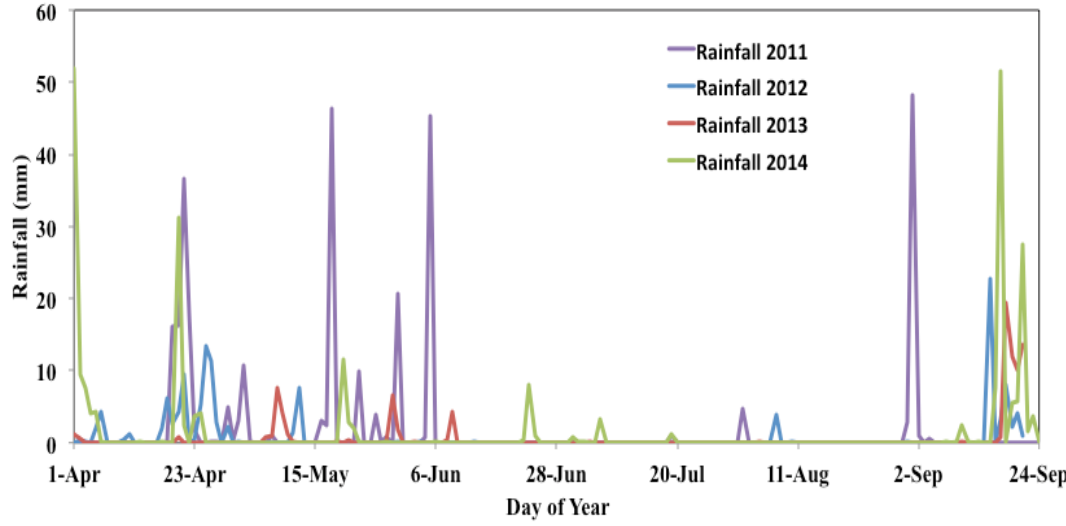
Figure 4. Daily rainfall during the four irrigation seasons of the study, from 2011 to 2014. Midday stomatal leaf conductance (g s ) was also influenced by the different DI regimes, as